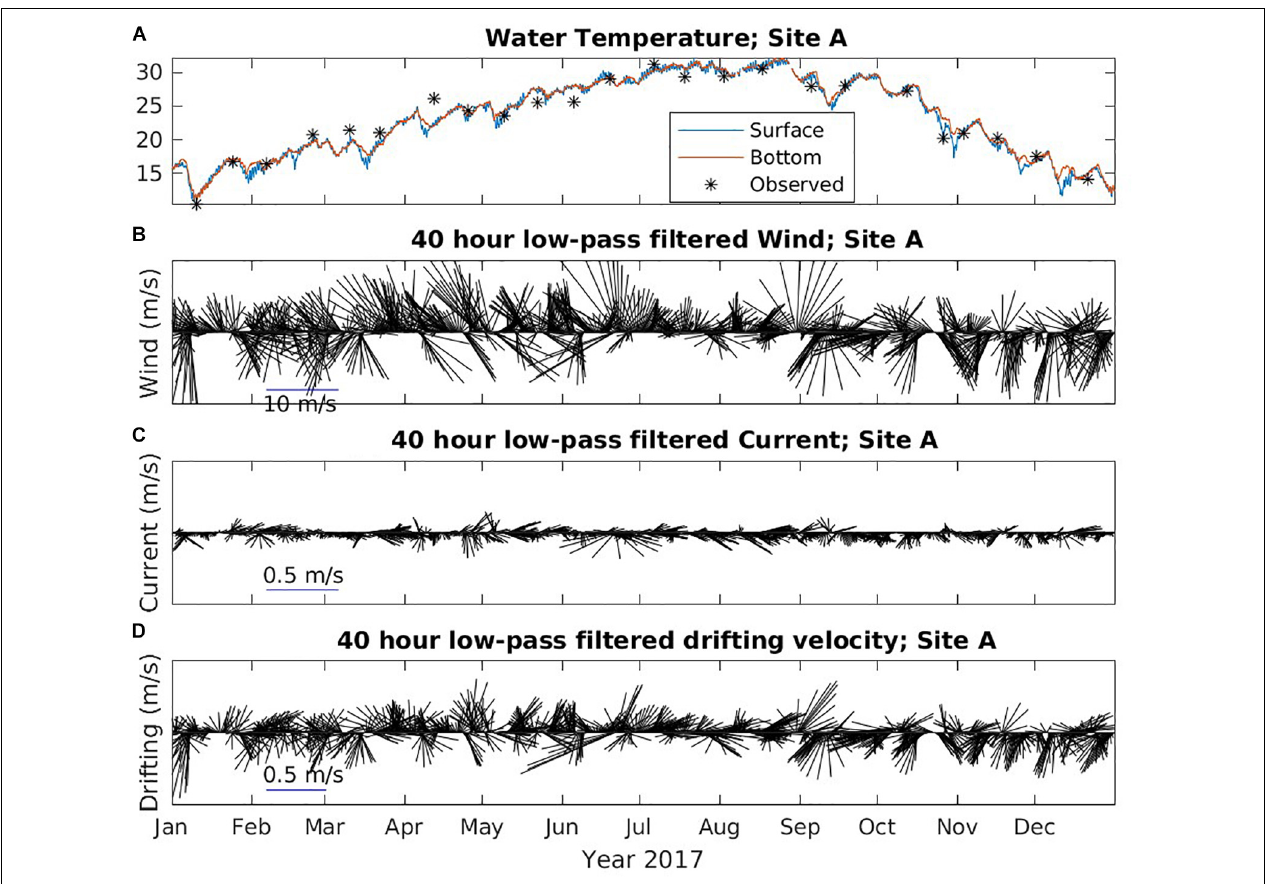
FIGURE 8 | Time series of environmental data at Site A from NGOFS. (A) Water temperature ( ◦ C); (B) Wind vector (m/s); (C) Surface current vector (m/s); and (D) drifting velocity vector (m/s). A 40-h low-pass filter was applied to wind, current, and drifting velocity to remove the fluctuations with periods less than 40 h. Vectors pointing “up” indicate northward